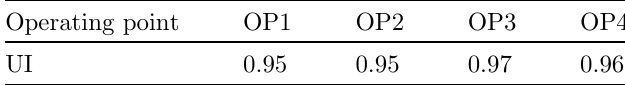
Table 6. Ammonia uniformity index with Pre-SCR.